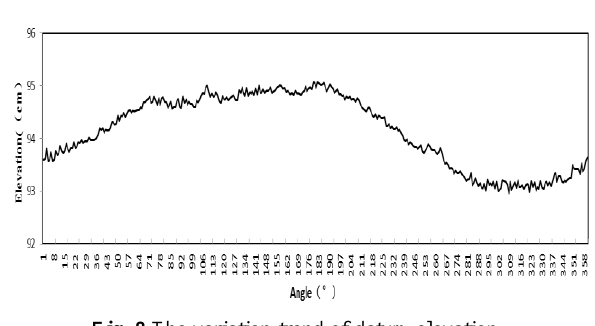
Fig. 8 The variation trend of datum